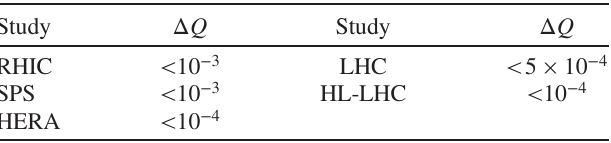
TABLE I. The critical modulation depth Δ Q as reported from previous studies in several accelerators [11,14,20 –